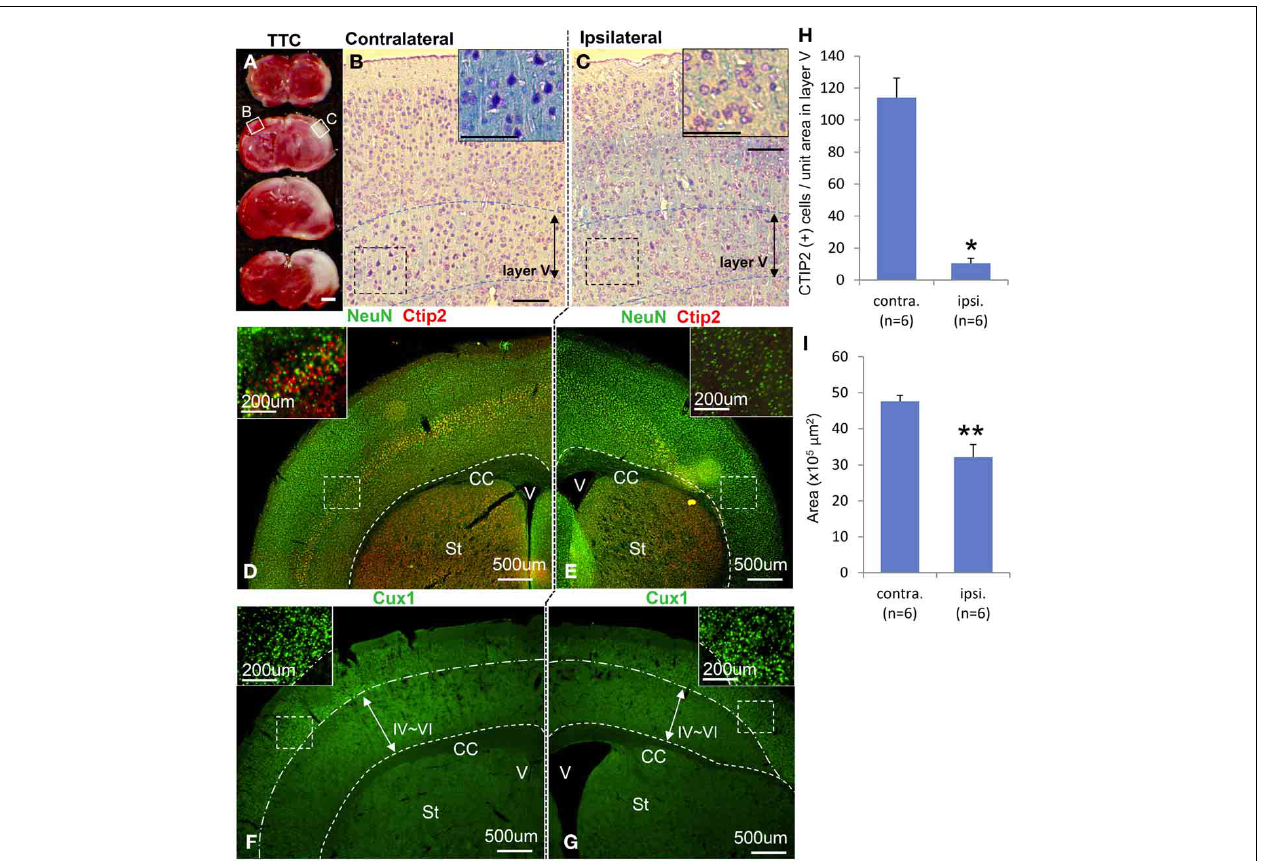
Ctip2 ( D and magnified insert), and superficial marker Cux1 ( F and magnified insert). Ctip2-positive neurons in the ipsilateral cortical area dramatically decreased ( E and magnified insert), while Cux1-positive cells in the superficial area are comparatively preserved ( G and magnified insert). (H) CTIP2 positive cells of unit-squared area (200 × 200 μ m) in randomly selected area in layer V cortex are represented by ipsilateral/contralateral hemisphere ( ∗ P < 0 . 0005). (I) The area of cortex is represented by ipsilateral/contralateral hemisphere ( ∗∗ P < 0 . 05). Scale bar: (A) 1000 μ m; (B,C) 100 μ m; (D–G) 500 μ m; ( D–G , magnified insert) 200 μ m; CC: corpus callosum, V: ventricle, St: